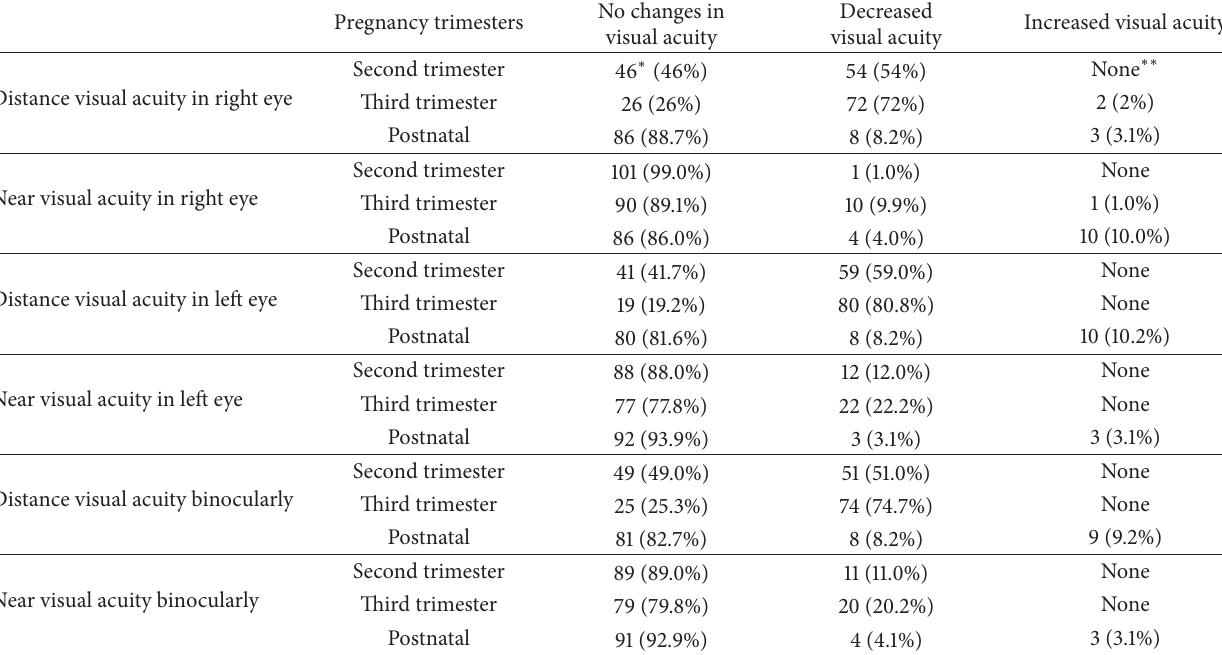
Table 2: Visual acuity changes in 2nd, 3rd, and postnatal trimesters compared to 1st trimester. Pregnancy